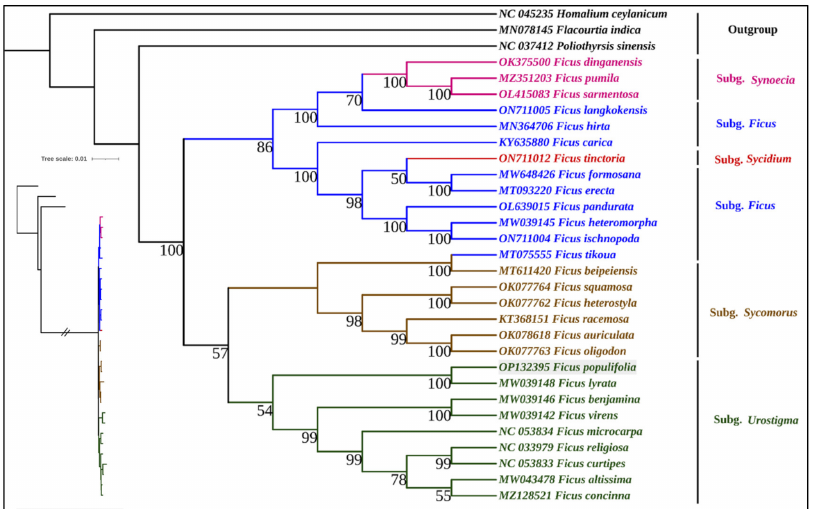
Figure 14. Phylogenomic relationship of 28 Ficus species based on 78 coding genes inferred from ML analysis. Bootstrap values are present below the lines.